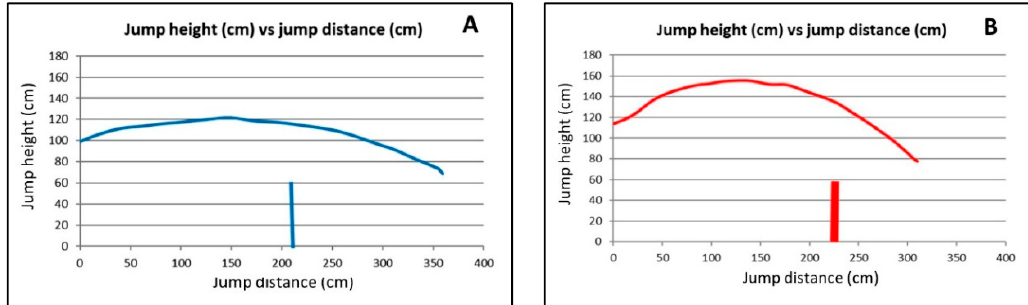
Figure 3. Graphic representation of the jump height (cm, y -axis) vs. jump distance travelled (cm, x -axis) of two agility dogs of di ff erent jumping abilities and competing at di ff erent levels. ( A ) dog number 1 of A group (excellent jumpers, competing in third and greater level of competition). ( B ) dog number 5, ranked as the worst jumper among all the dogs in group B (less-skilled jumpers, competing in second and lesser level of competition). Vertical line represents the 60-cm hurdle.